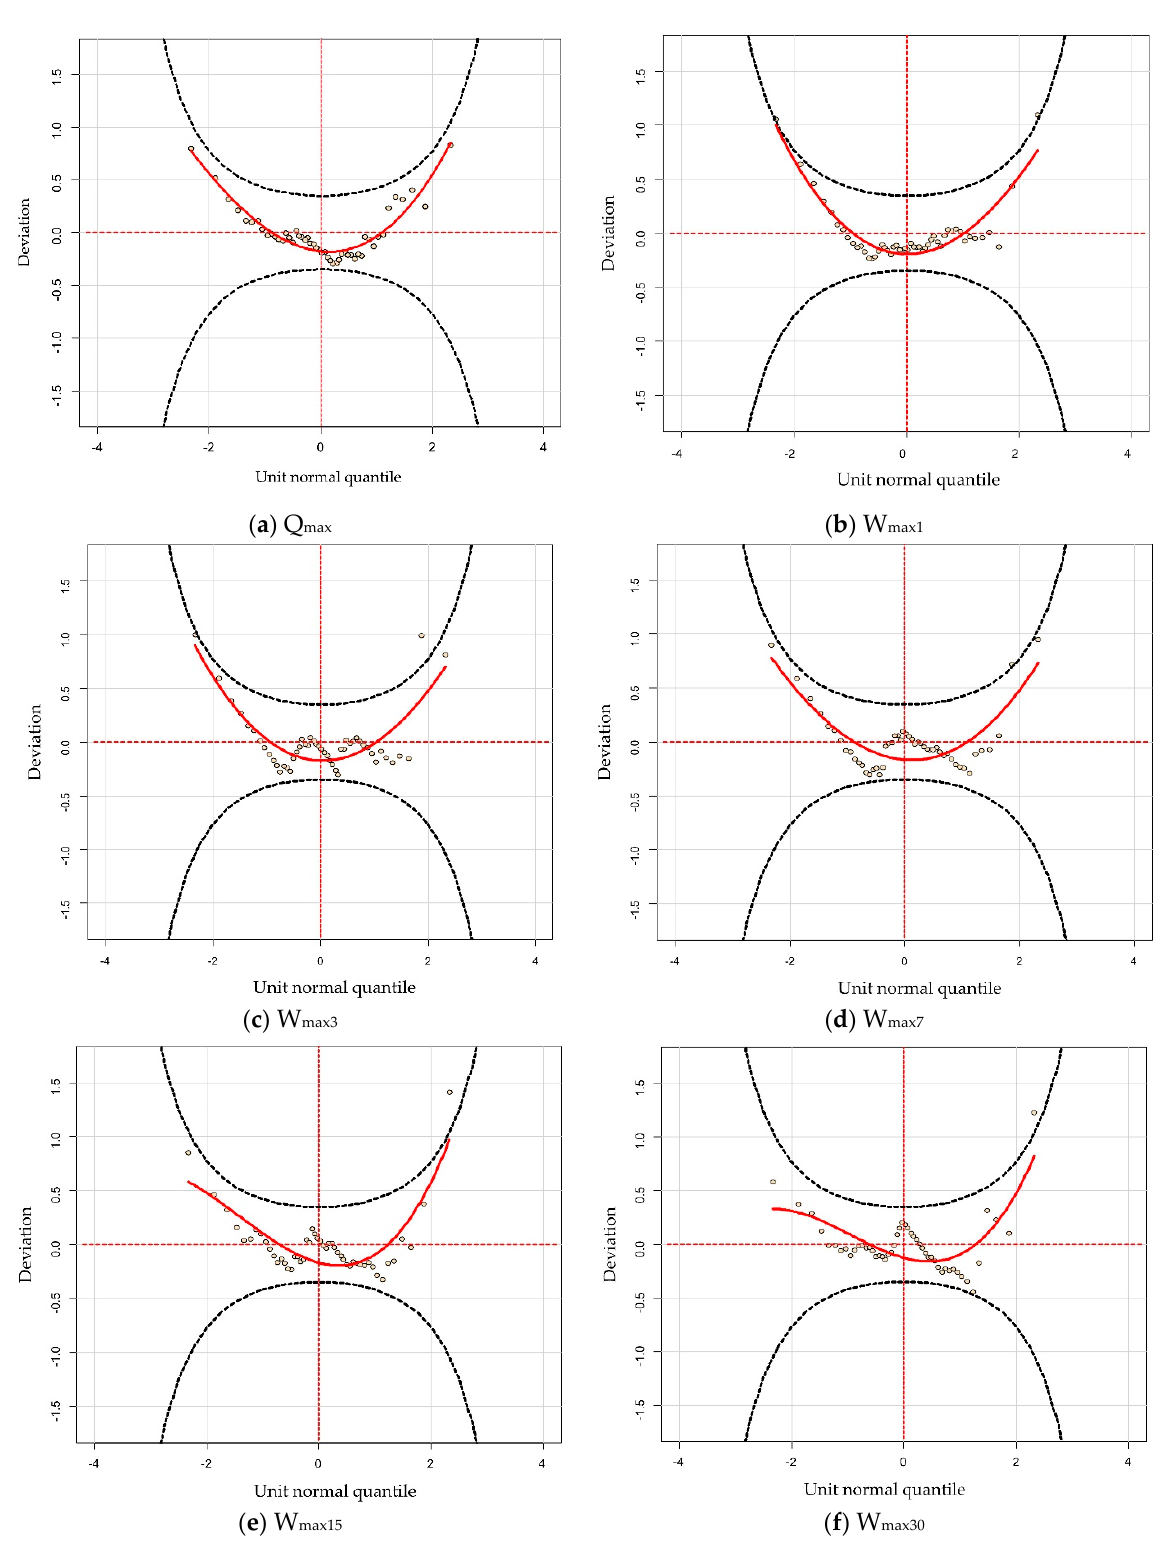
Figure 3. Worm plots of model 0 residuals. The two black dotted lines correspond to the 95% confident limits.